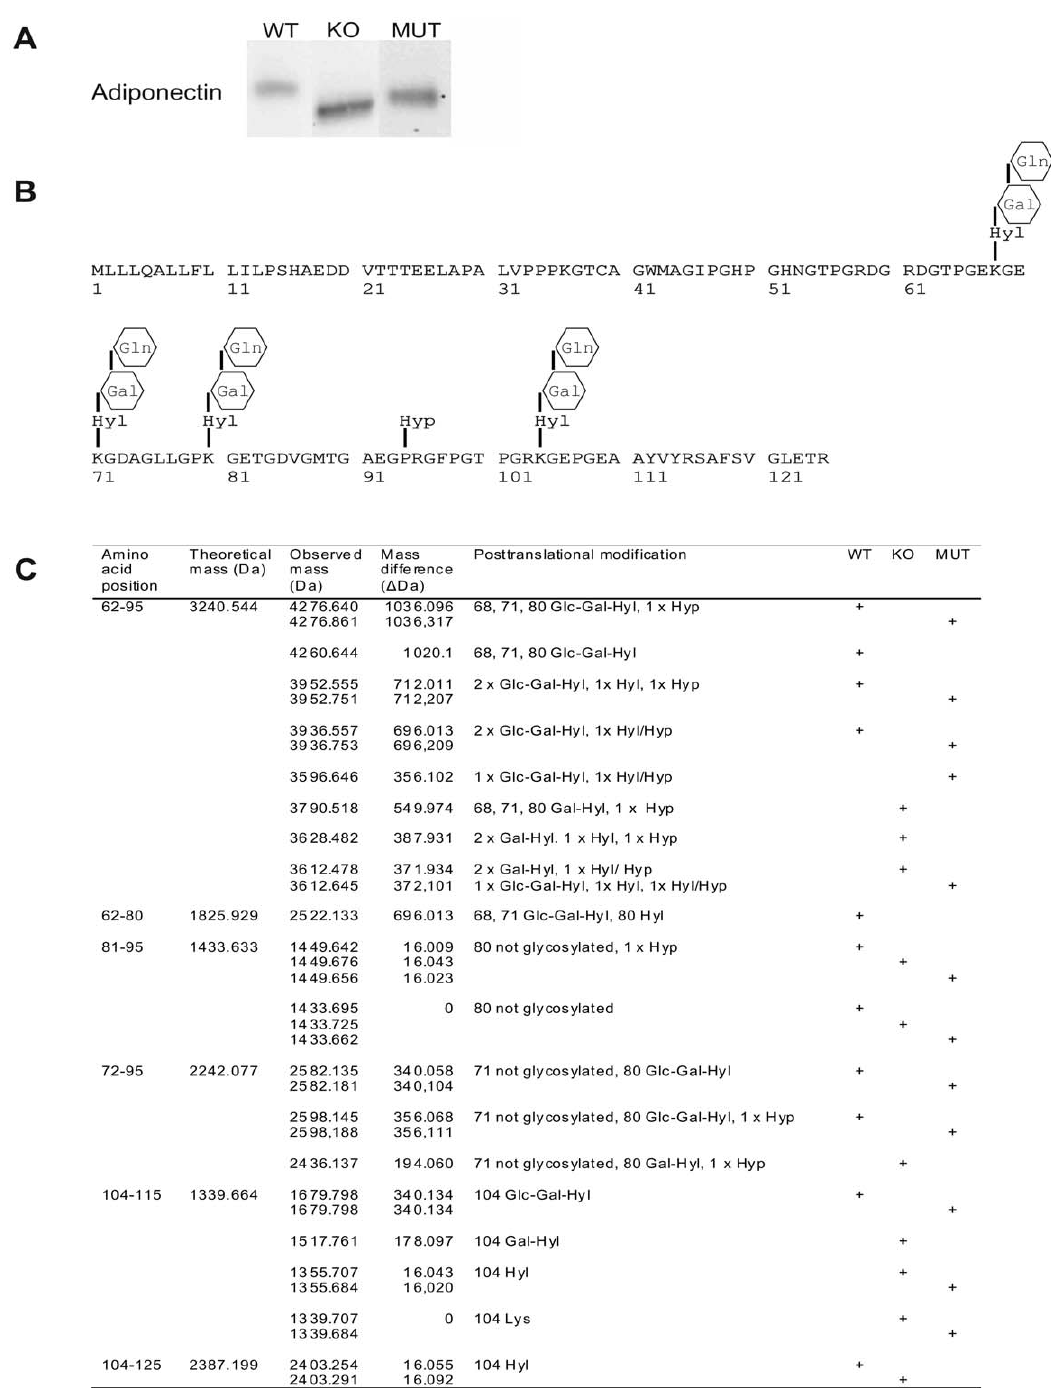
Figure 1. Immunoblot and mass analyses of adiponectin produced in LH3 manipulated cell lines. (A) Recombinant adiponectin was produced in MEF cells and the medium containing the secreted adiponectin was collected for the analysis. The immunoblot analysis of recombinant adiponectin monomers from the concentrated medium of wild type, LH3 2 / 2 knockout and LH mutant MEF cells indicates a clear size difference. (B) Schematic picture of the collagenous domain of mouse adiponectin shows the positions of posttranslational modifications of lysine and proline residues reported earlier. (C) Mass spectrometry identification of peptides and modifications from tryptic digests of mouse adiponectin produced in wild type, LH3 2 / 2 knockout and LH mutant MEFs. Abbreviations: WT=wild type; KO=LH3 2 / 2 knockout; MUT=LH mutant; Hyl=hydroxylysine; Gal=galactosyl; Glc=glucosyl. doi:10.1371/journal.pone.0050045.g001 always glycosylated. Trypsin cleavage is known to occur at C- not at Glc-Gal-Hyl residue [26]. However cleavage was not always terminal peptide bond of arginine, lysine and hydroxylysine but quantitative since fragment 104–125 contains an internal mis-